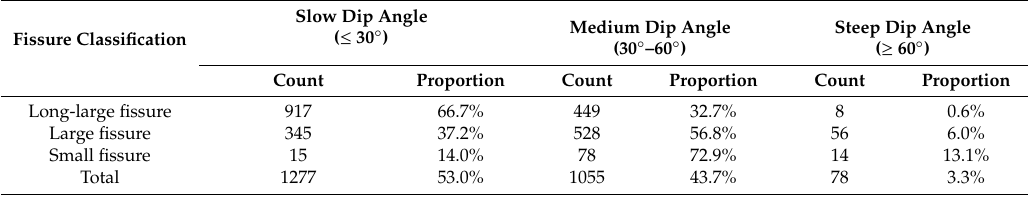
Table 1. Statistical table of fissure dip angle of Nanyang expansive soil